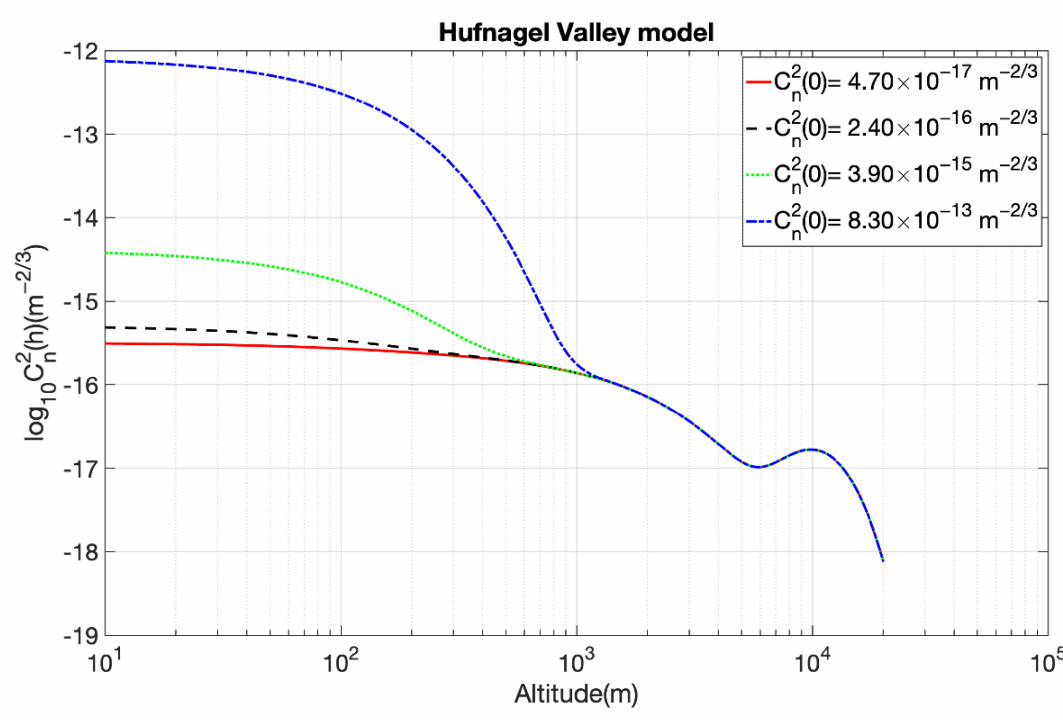
Figure 3. The Hufnagel Valley empirical